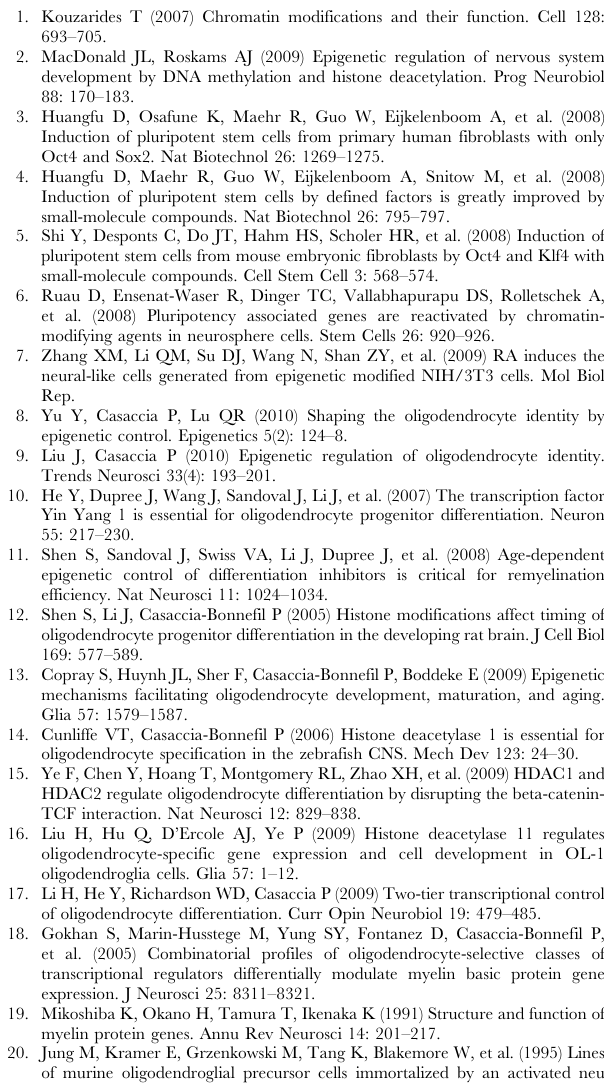
Figure S1 The pattern of histone code on the b actin gene was similar during oligodendrocyte progenitor differentiation. The pattern of histone modifications in beta-actin proximal promoters was analyzed in proliferating (OPC) and differentiating (OPC diff) rat primary oligodendrocyte cultures. Note that the histone code of this constitutively expressed gene was similar at the two stages of